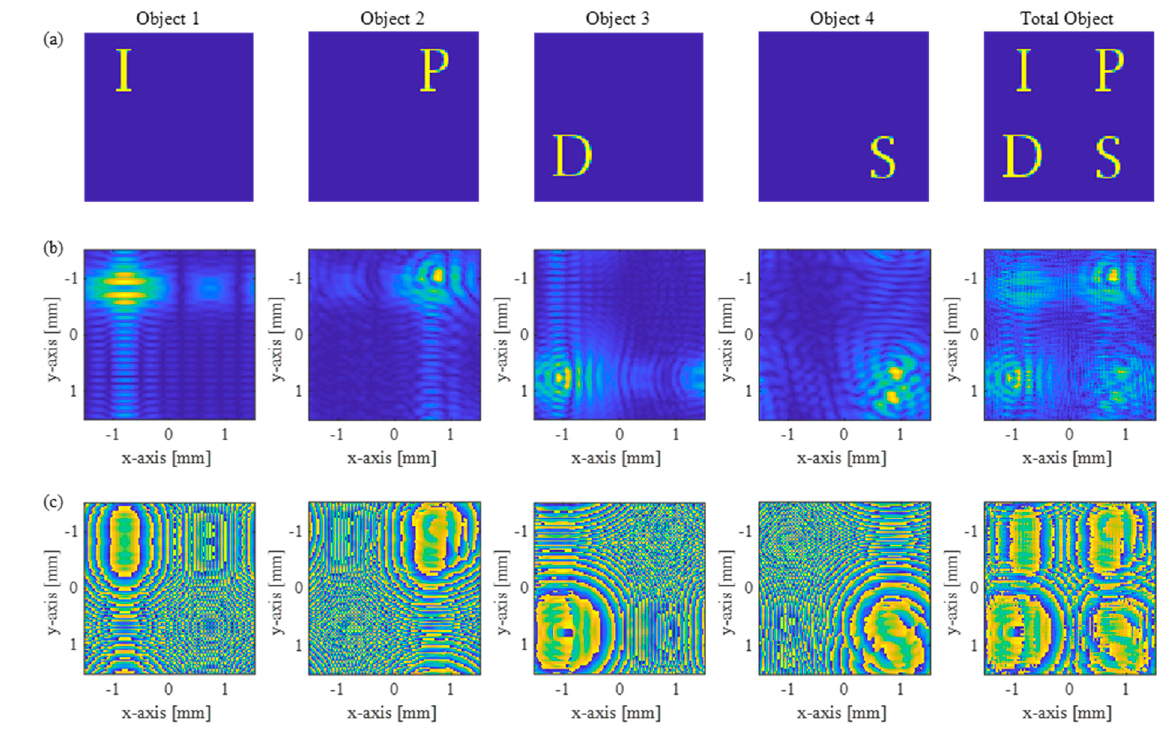
Figure 5. The complex hologram by the proposed scheme. ( a ) Four letter target objects of ‘I’, ‘P’, ‘D’, and ‘S’ where their depths from the image sensor (Hologram plane) are set to (100 mm, 90 mm, 80 mm, and 70 mm). ( b ) Amplitude profiles and ( c ) phase profiles of each incoherent complex hologram synthesized by the SIDH system.